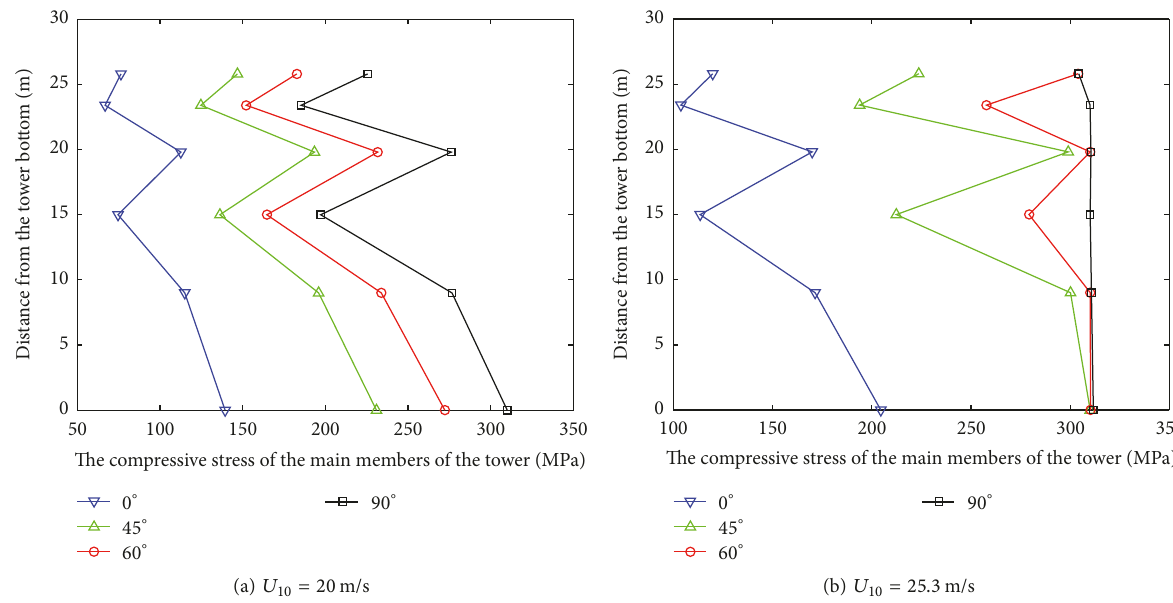
Figure 25: Comparison of the axial compressive stress of the main members of the tower in the tower-line system calculated using dynamic analysis under different wind directions.